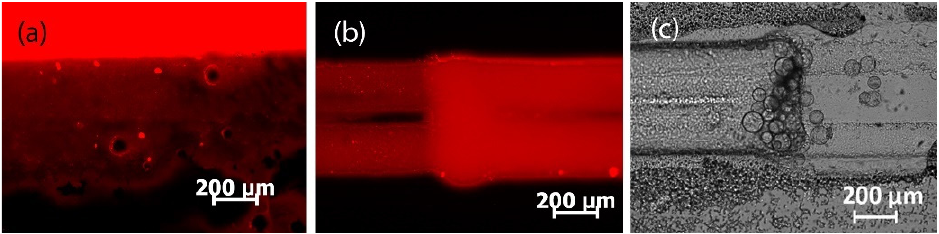
Figure 13. Microfluidic chip replicated from a Form 2-printed casting mold. ( a ) Leakage around channels visualized with fluorescent rhodamine B solution. ( b ) Sieve visualized with fluorescent rhodamine B solution. ( c ) Sieve with retained particles.